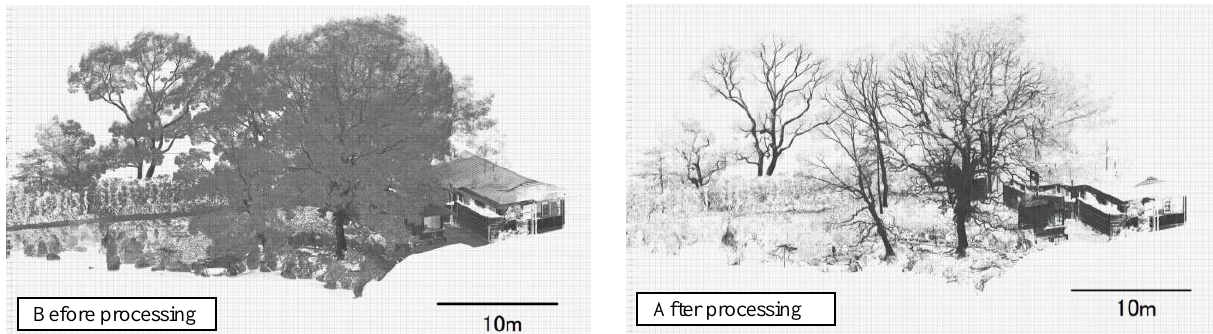
Figure 5. Classification using deviation and